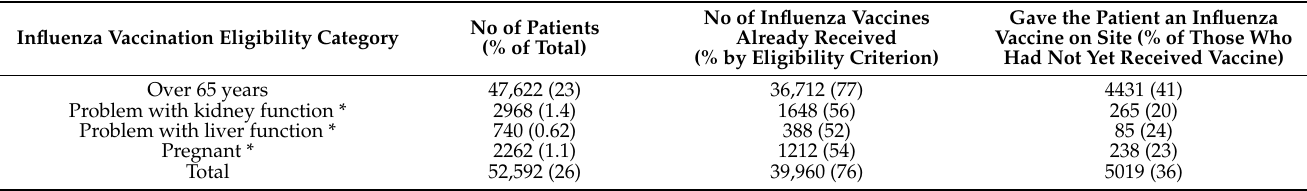
Table 3. The number of TARGET Antibiotic Checklists indicating patients were eligible to receive a free influenza